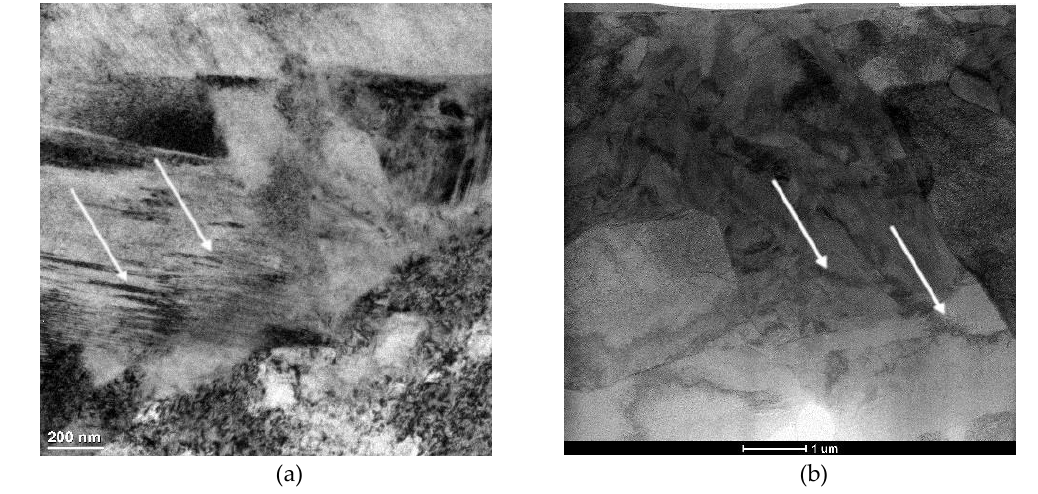
Figure 4. TEM image of the specimen deformed at 200 °C: martensitic laths (bright field)—( a ), dislocation cells (high-angle annular dark-field imaging (HAADF) scanning-transmission electron mode (STEM))—( b ).